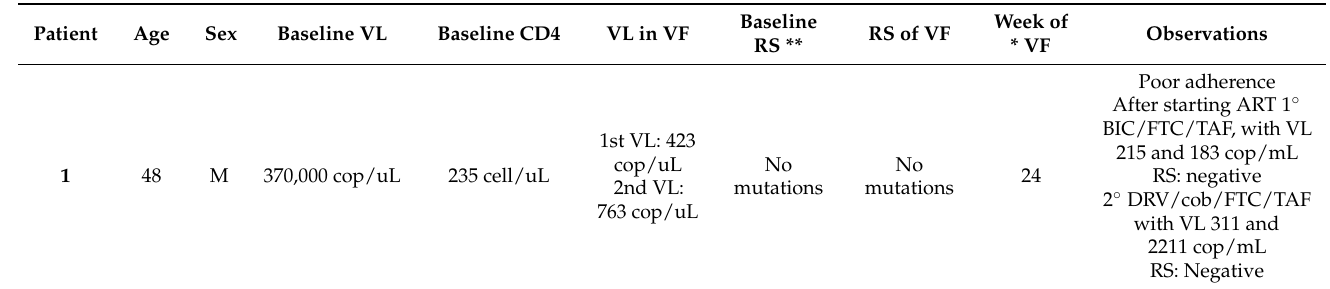
Table 2. Virological failures.